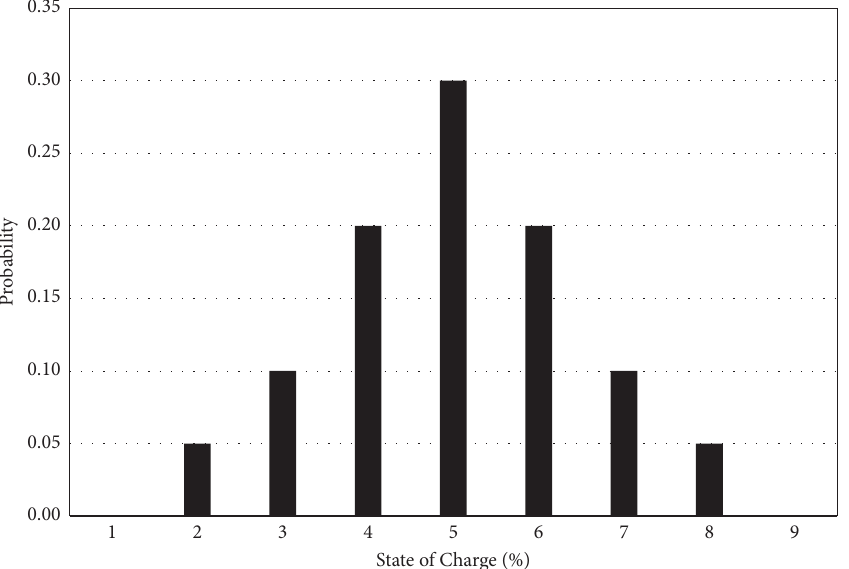
Figure 4: Probability density function of the state of charge (SoC).